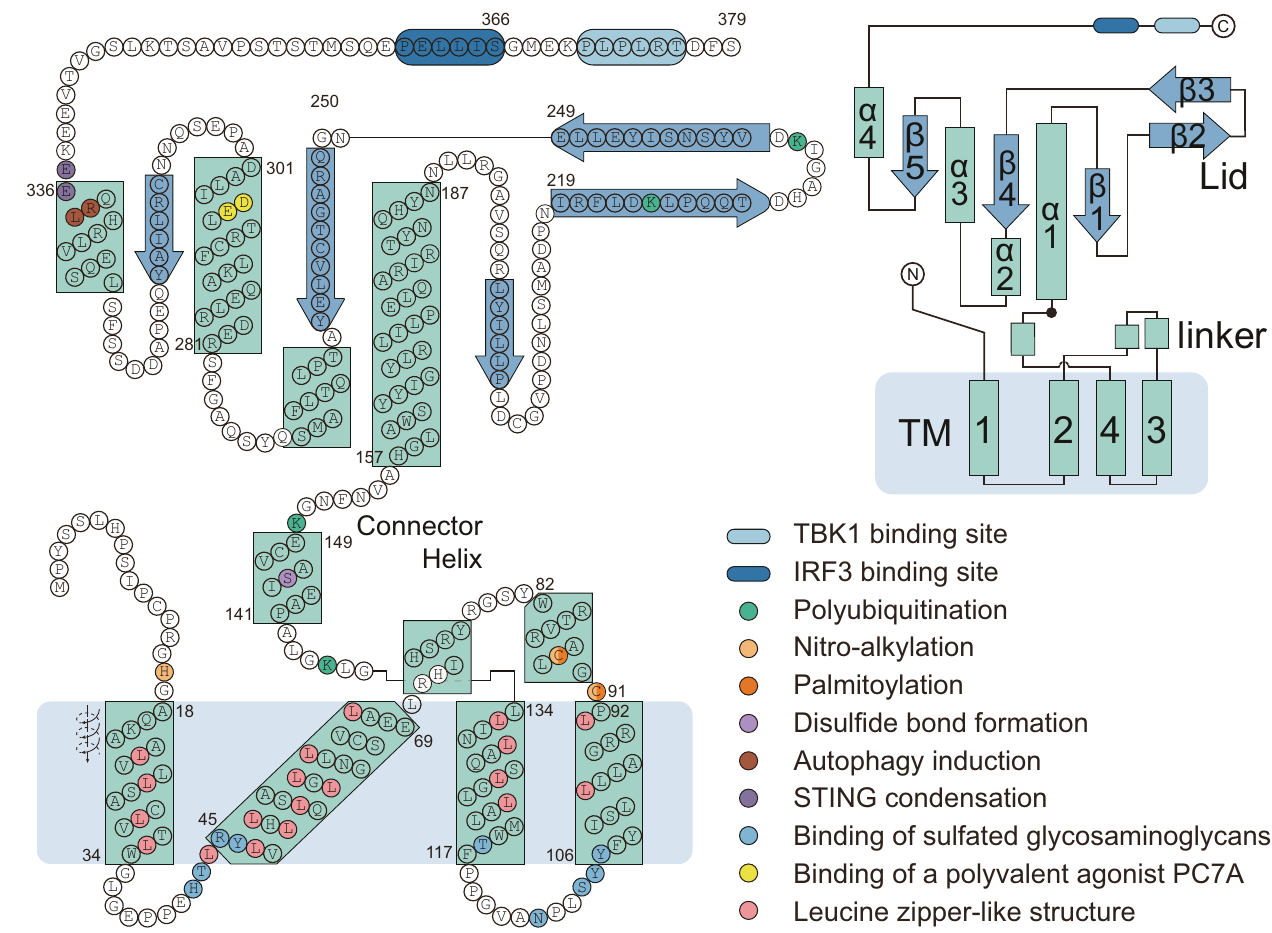
Fig. 5 Domain composition and sequence of human STING. Functional residues are marked with colors and annotated in the right-bottom panel. The arrangement of α -helix and β -strands is annotated in the right-upper panel. PC7A polymer with a cyclic seven-membered ring